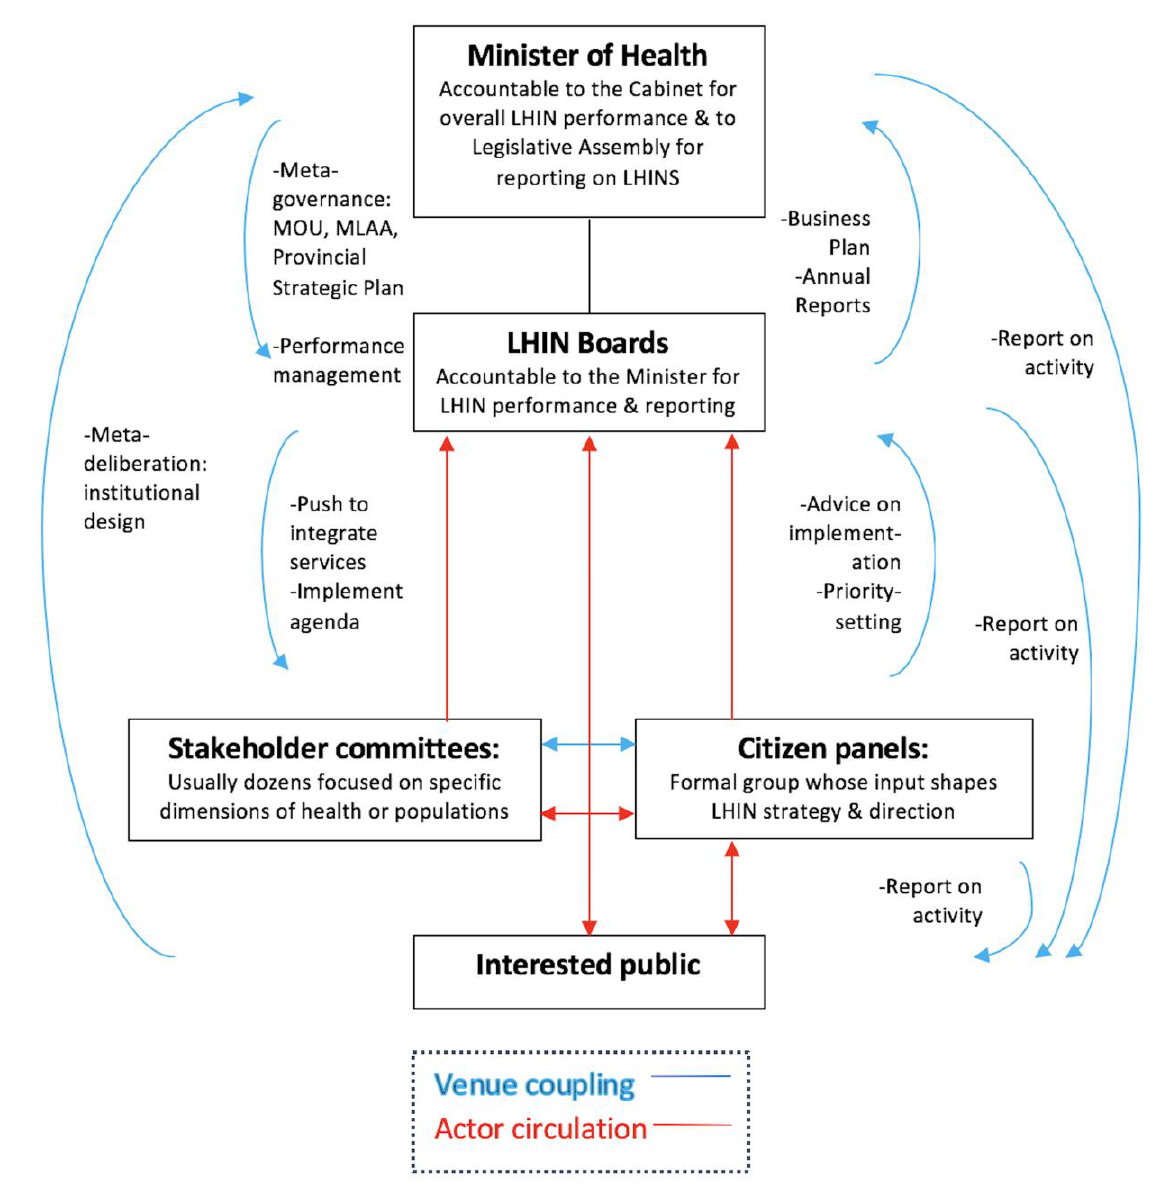
Figure 1 : Chart of authorities and ideal relationships in the LHIN context. Note: Boxes indicate key venues in the LHIN governance system, blue arrows reference elements of venue coupling, and red arrows reference circulation of actors across venues, all as an ideal